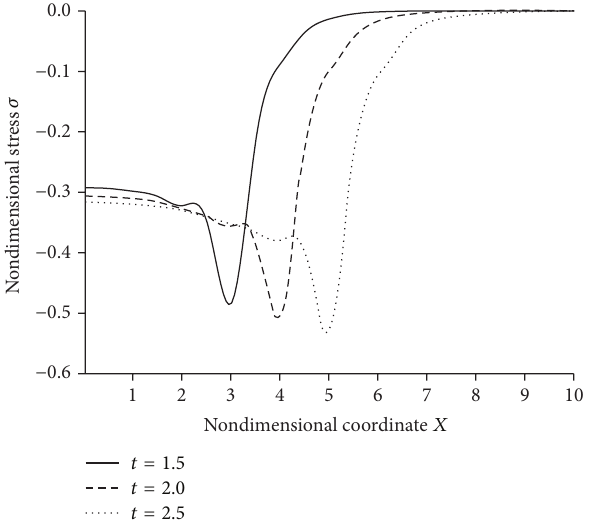
Figure 4: Nondimensional temperature distribution for different 𝜐 values.